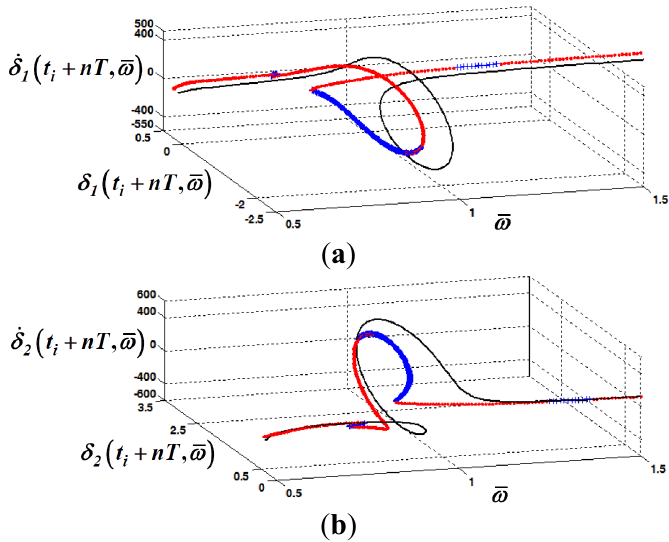
t  and ( b ) RMS values of   t  . 1 2